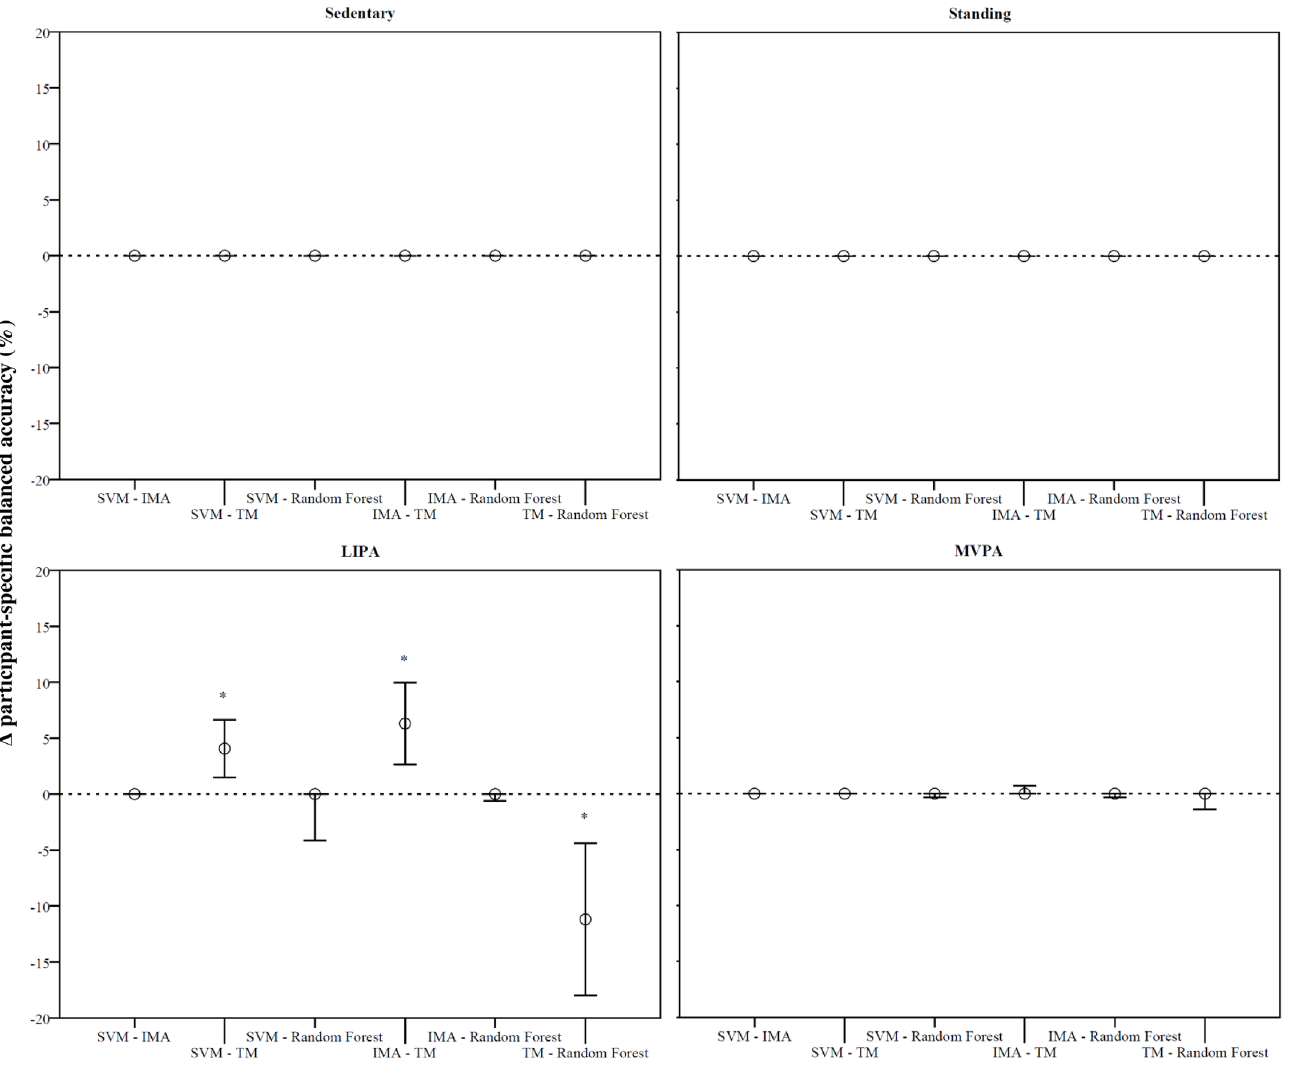
Fig 2. Pairwise comparisons between algorithms per intensity using participant-specific balanced accuracies. SVM, sum of vector magnitudes; IMA, integralsof the moduliof acceleration signals; TM, total movement; LIPA, light-intensityphysicalactivity; MVPA, moderate-to- vigorous physicalactivity; Error bars represent 95%-confidence intervals; Dashedline represents no difference; * P < 0.05.